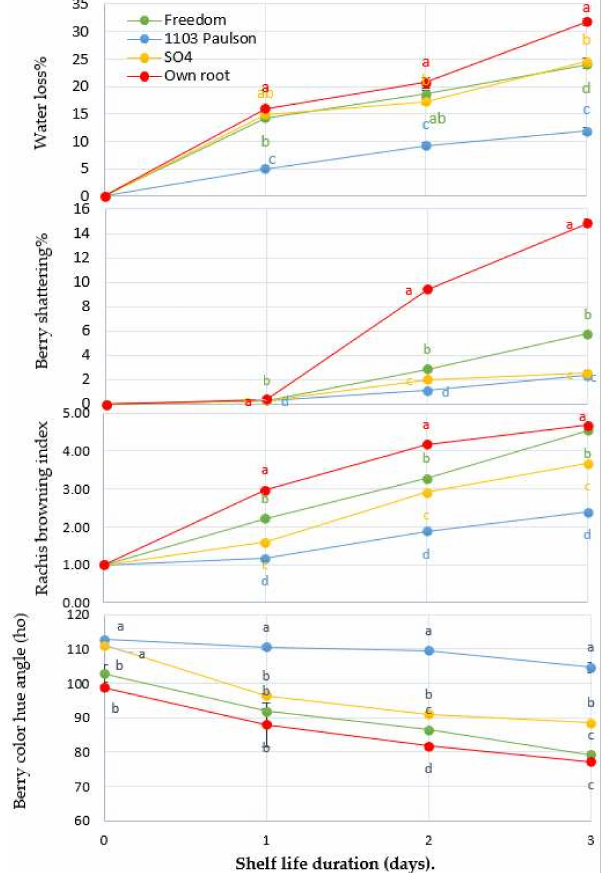
Figure 1. The effect of Superior Seedless grapevine rootstocks (Freedom, 1103 Paulsen, SO4, and Own Root) on water loss, rachis browning index, and berry color hue angle during three days of shelf life (27 ± 1 ◦ C with 57 ± 3% RH). The vertical bars represent ± SE ( n = 3), and significantly different samples, according to Tukey’s HSD test at 5%, are indicated by different